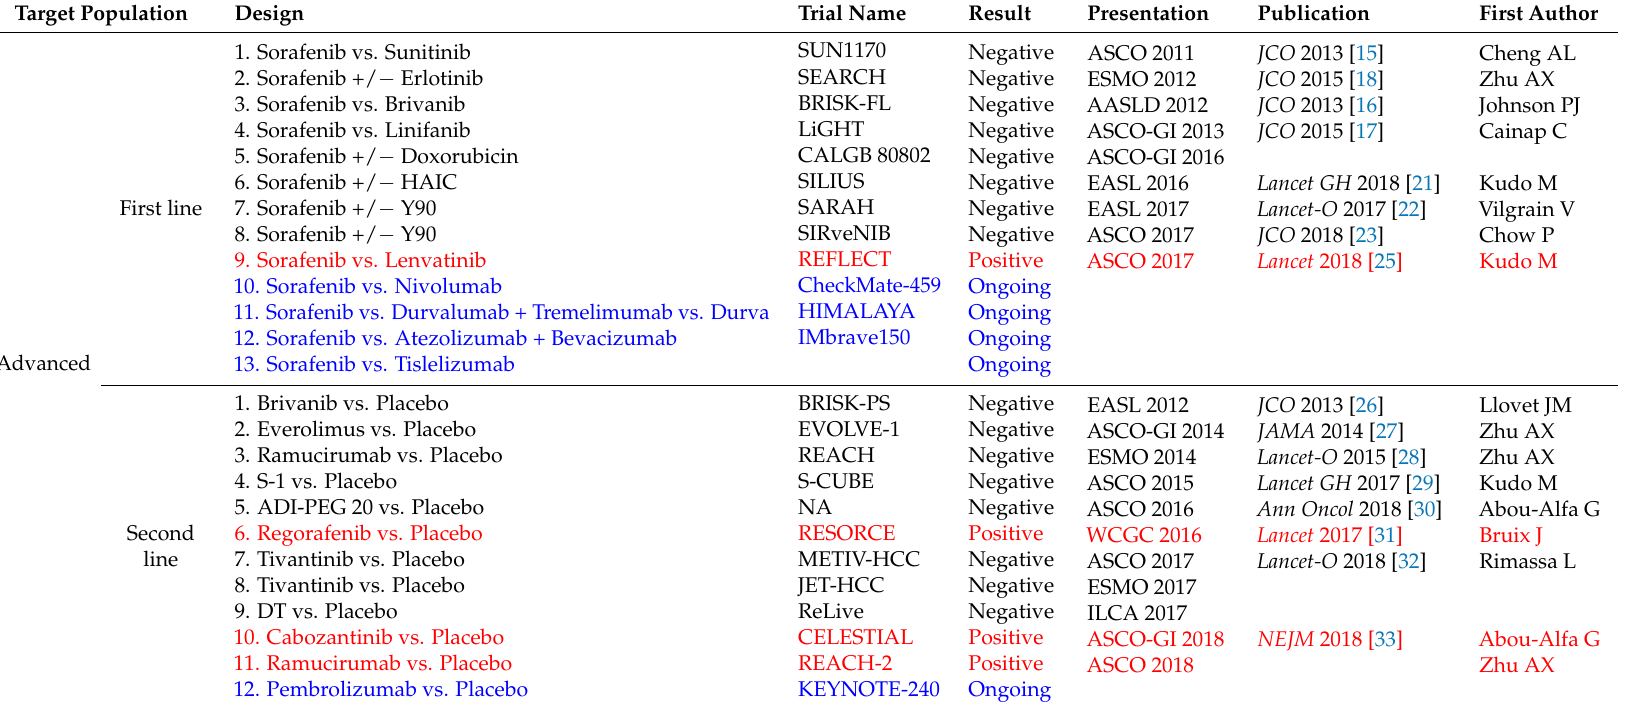
Table 2. Phase III clinical trials of advanced-stage